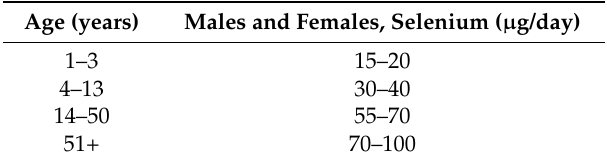
Table 2. Recommended dietary allowances (RDAs) for selenium